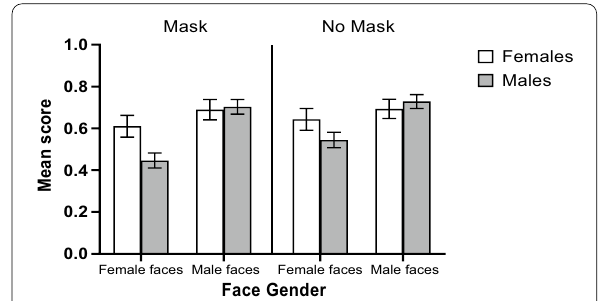
Fig. 5 Average accuracy scores of male and female observers for masked and unmasked faces by face gender in the famous face identification task. Note: p > 0.05(ns), * p p ≤